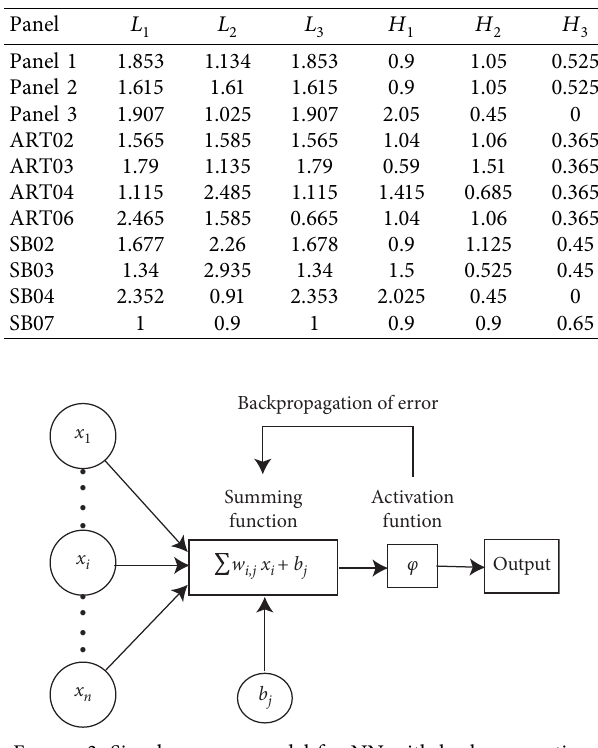
Table 2: Configuration of panels with opening according to the CA model.